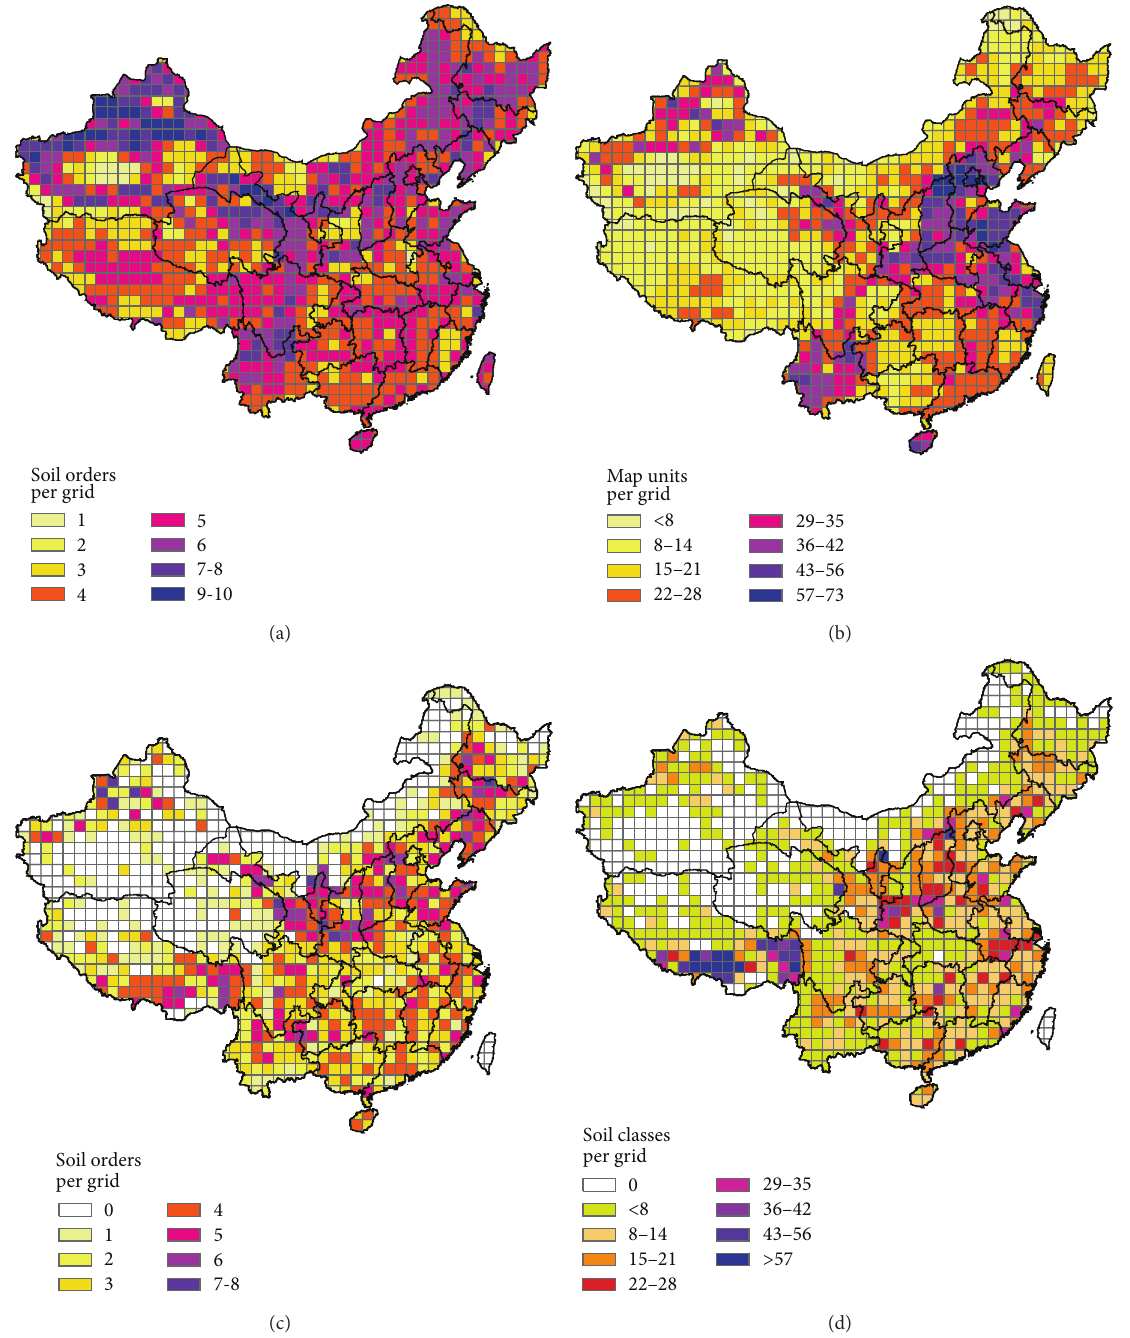
Figure 3: Soil orders (a) and soil map units at lower taxonomic levels (b) per grid in China based on soil map and soil orders (c) and soil classes at lower taxonomic levels (d) per grid in China based on soil profiles. Each grid is 100km × 100km in area. (The taxonomic level of the soil map is shown in Figure